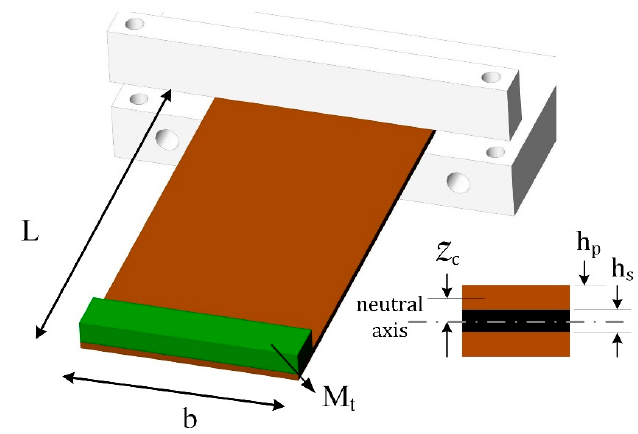
Figure 4. Piezoelectric bimorph with a tip mass.